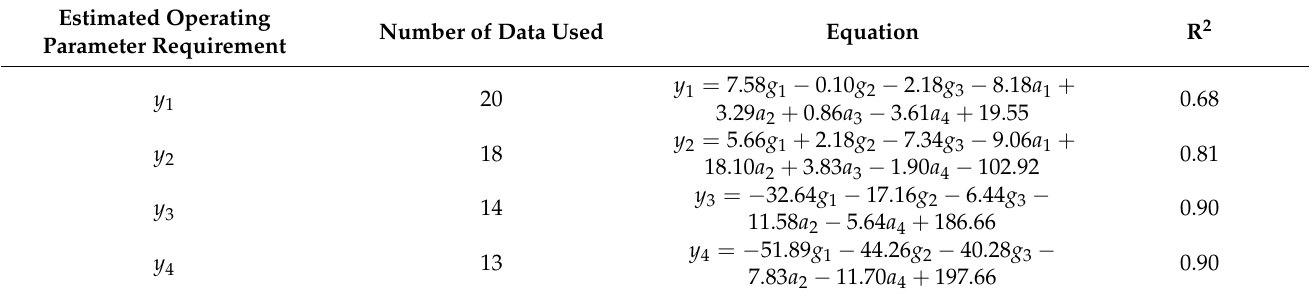
Table 2. Summary of regression equations estimating operating parameters for soil excavation. Estimated